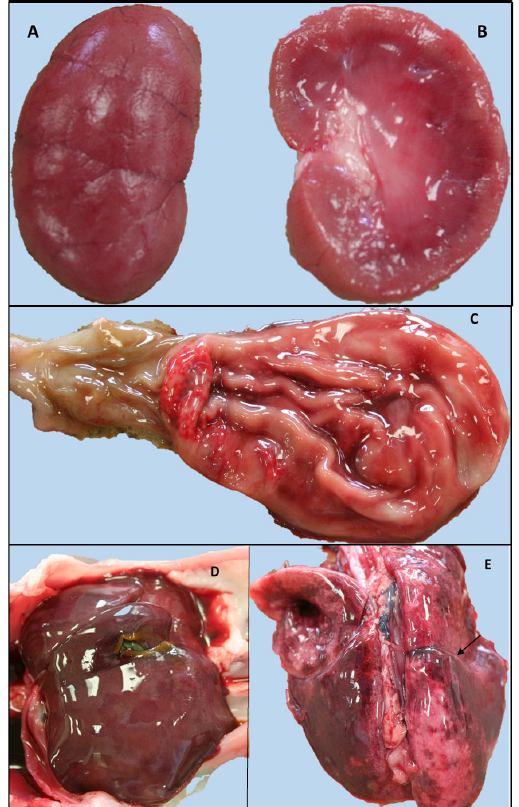
Figure 1 . Gross findings of the kitten positive for FPV and Leptospira interrogans serogroup Australis ST 24. ( A ) Left kidney dorsal and longitudinal section: multifocal, ill-defined cortico-midline demar- cation and a prominent renal cortex with multifocal, rarely coalescent, bright red radial striations. ( B ) Stomach and proximal intestine (duodenum): catarrhal-haemorrhagic gastritis, erosive altera- tion of the mucosa of the pyloric region. ( C ) Increased size of the liver with blurred margins and slight diffuse prominence of the parenchyma. ( D ) Severe pulmonary edema and haemorrhagic suf- fusions: area of adhesion between the middle and caudal lobes of the right lung (arrow) ( E ). Bacteriological samples from intestine, liver and lung were positive for Escherichia coli, whereas Salmonella spp. analysis tested negative. Finally, gastrointestinal samples tested positive for the molecular detection of FPV (Ct 23.01) (stomach and small intestine tissue samples). Bacterial culture tested negative for Leptospira spp. (kidney, lung and liver). The molecular analysis reported positivity for Leptospira spp. only in the kidney tis- sues (Ct 35.95), while lung and liver resulted negative . The Leptospira DNA, submitted to an MLST analysis, was typed as Leptospira ST 24, which identifies L . interrogans serogroup Australis.